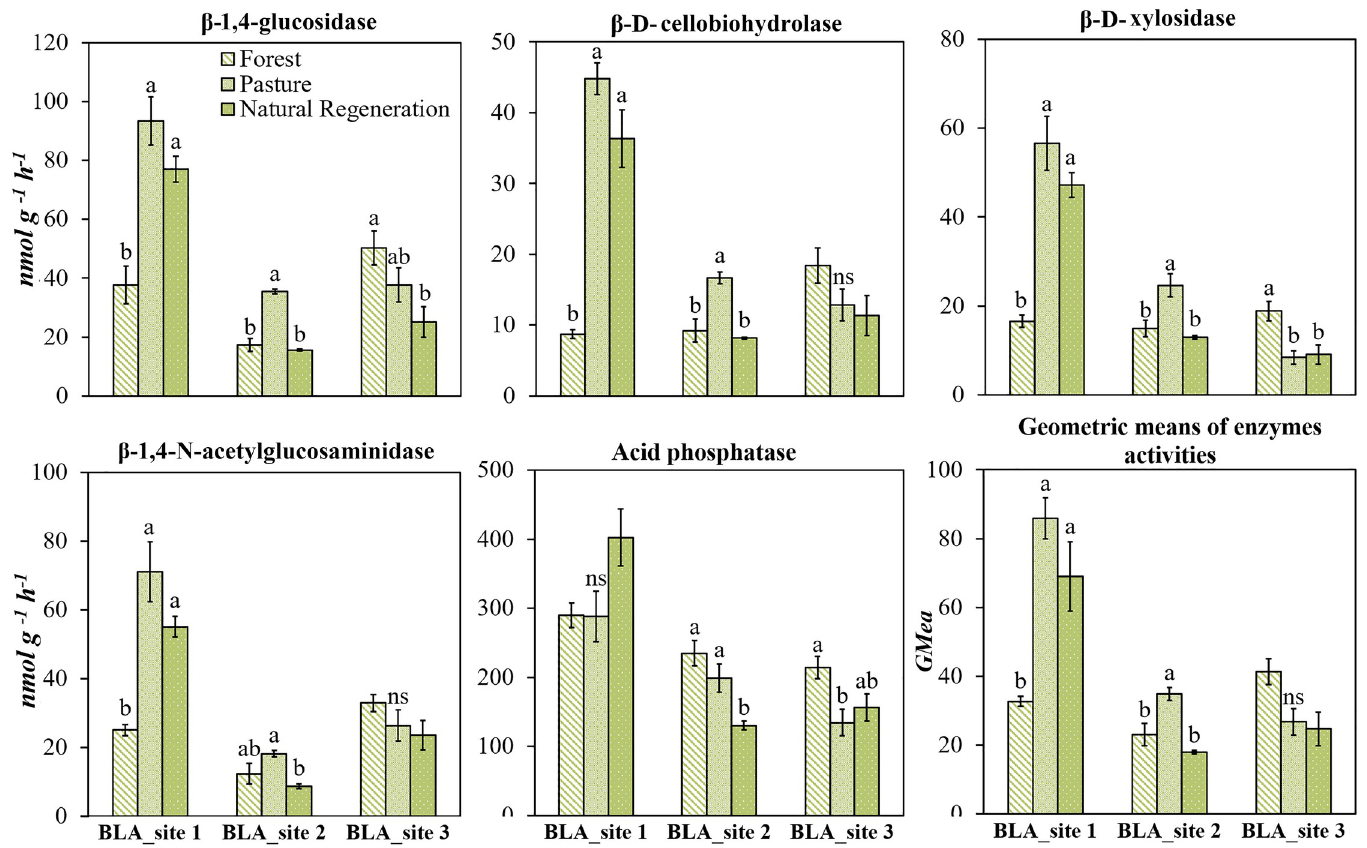
Fig 5. β -1,4-glucosidase, β -D-cellobiohydrolase, β -D-xylosidase, β -1,4-N-acetylglucosaminidase and acid phosphatase enzymes activities, and GMea in the soil of forest, pasture and natural regeneration in mountain landscape sites over an Andes-Amazon transition in Colombian Amazon region. Error bars denote standard error. Means followed by the same letters, above the bars, did not differ significantly according to Tukey’s HSD test ( p < 0.05), using “lmer” model.